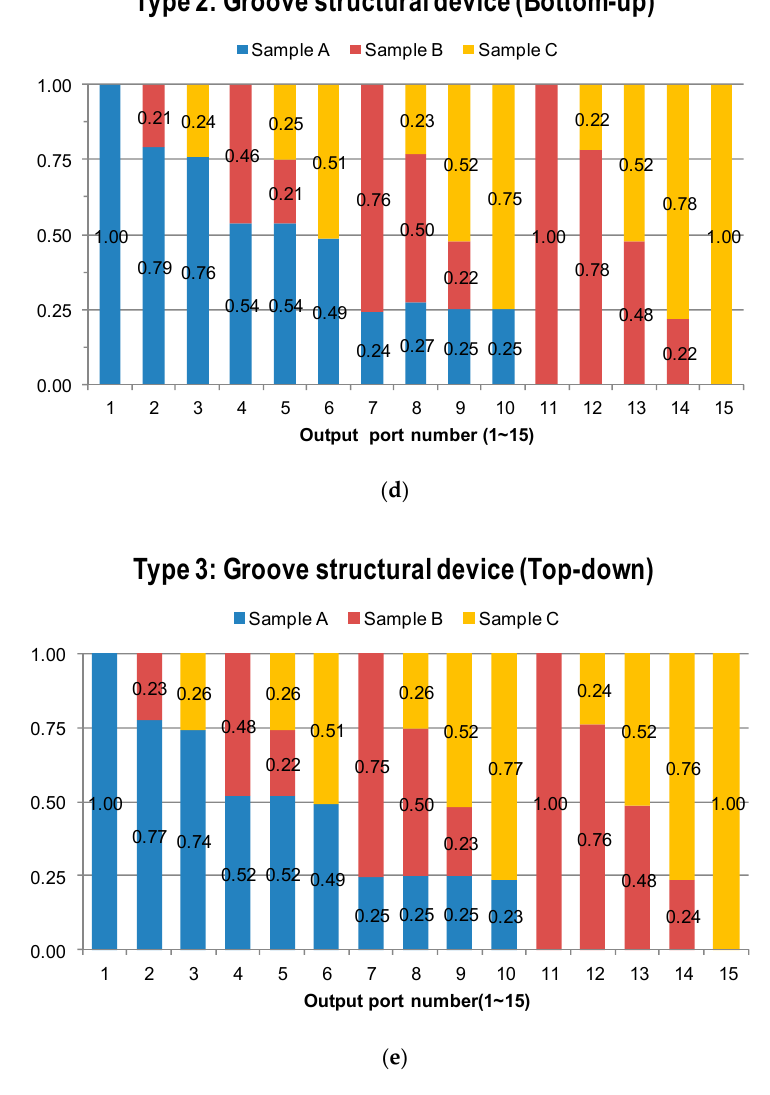
Figure 5. Fluorescent experimental results for the microfluidic combinatorial devices. ( a ) The images of the fabricated polydimethylsiloxane (PDMS) devices for bottom–up and top–down liquid retrievals. ( b ) Images in the mixing stages indicated in Figure 5a, the two fluids were evenly merged in the mixing stages. Results of quantitative analysis for ( c ) the plain structural combinatorial device (Type I), ( d ) the groove structural combinatorial device using bottom–up liquid-handling method (Type II), and ( e ) the groove structural combinatorial device using top–down liquid-handing method (Type III).